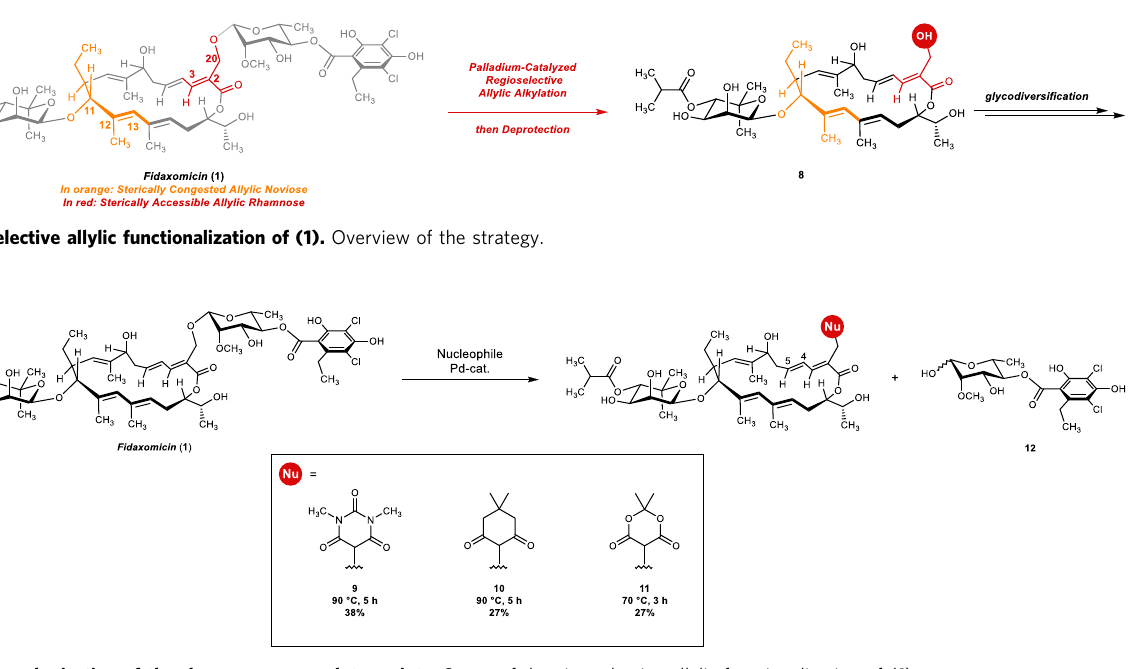
Fig. 10 Allylic substitution of the rhamnose-resorcylate moiety. Scope of the site-selective allylic functionalization of ( 1